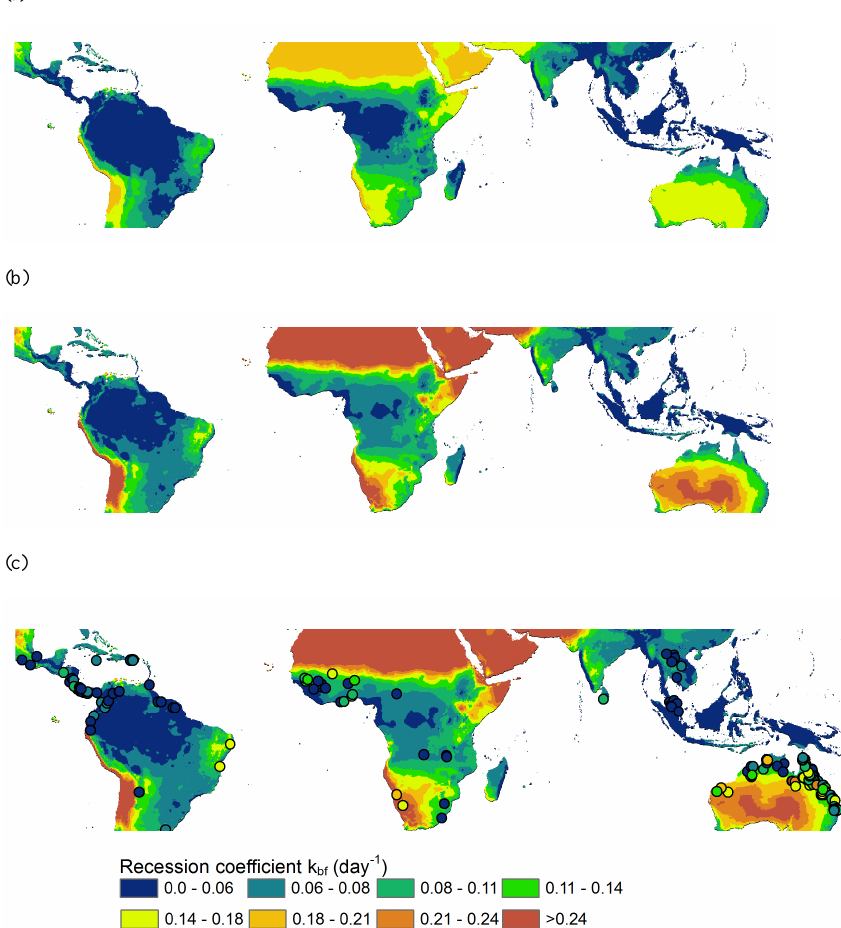
Fig. 9. Pan-tropical map of baseflow recession coefficient using the exponential regression equation and mean annual rainfall (MAR): (a) equation representing the lower and (b) upper bounds of the 95% confidence interval and (c) original regression equation. Symbol colours represent estimated k bf values of the 167 catchments used in this study.